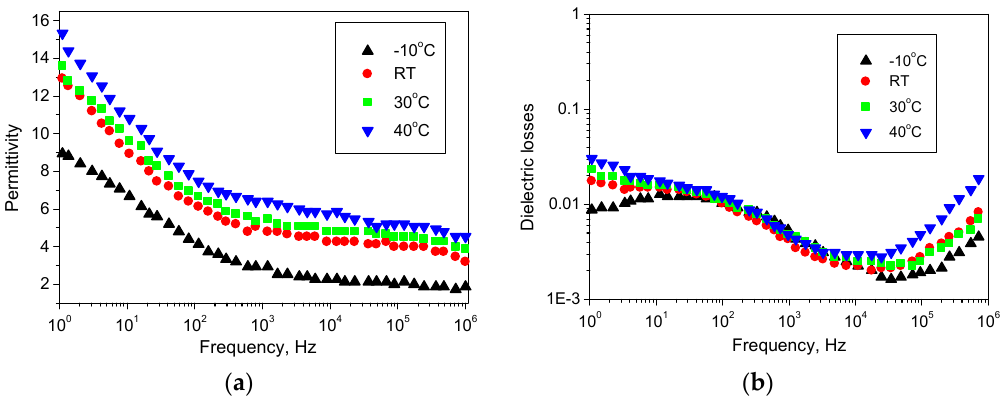
Figure 4. Frequency dependence of the ( a ) relative permittivity and ( b ) dielectric losses at different temperatures for the non-bended sample PET/PEDOT:PSS/ZnO/PEDOT:PSS/Au.